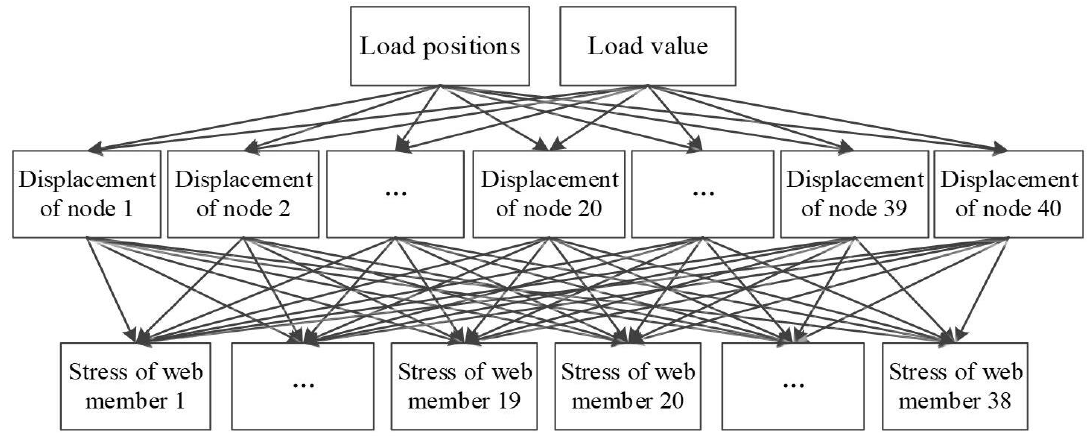
Figure 1. The GBN structure.